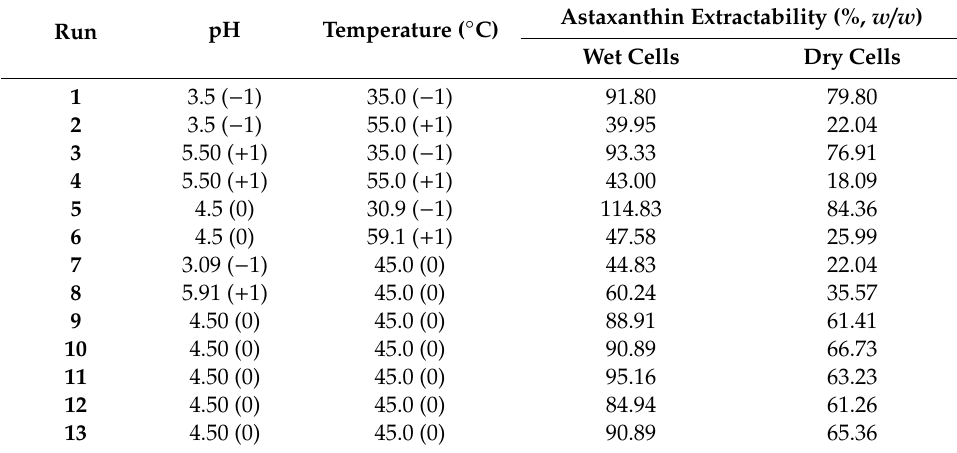
Table 2. E ff ect of pH and temperature on astaxanthin extractability (%, w / w ) of dry and wet samples of X. dendrorhous DSMZ 5627 cells after treatment with